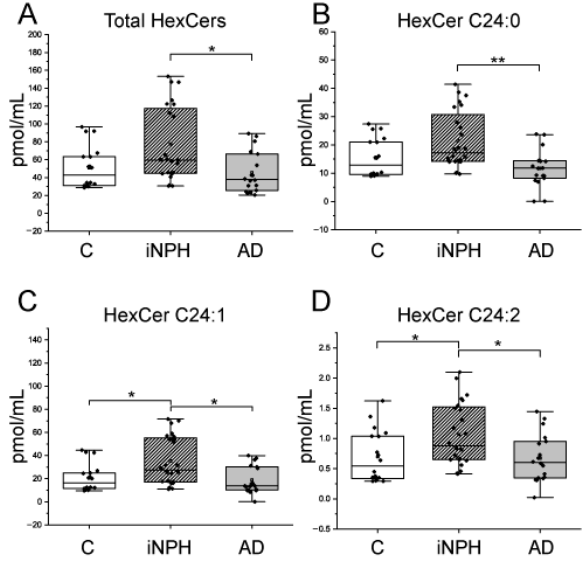
Figure 2. Box plots of CSF hexosylceramide (HexCer) species changed in iNPH and AD patients compared to C subjects. ( A ) Total HexCers, ( B ) HexCer C24:0, ( C ) HexCer C24:1, ( D ) HexCer C24:2. Each measurement was run in triplicate. Data were analyzed using Kruskal–Wallis ANOVA, followed by Dunn’s post hoc test for multiple comparisons. * p -value < 0.05, ** p -value < 0.01. Regarding SMs, CSF from iNPH and AD patients showed higher levels of SM C24:1 and lower levels of SM C24:2 compared to C (Figure 3). For all sphingolipids, ROC curves and AUC values were calculated (Table 2). Table 2. AUC values for Cers, HexCers and SMs